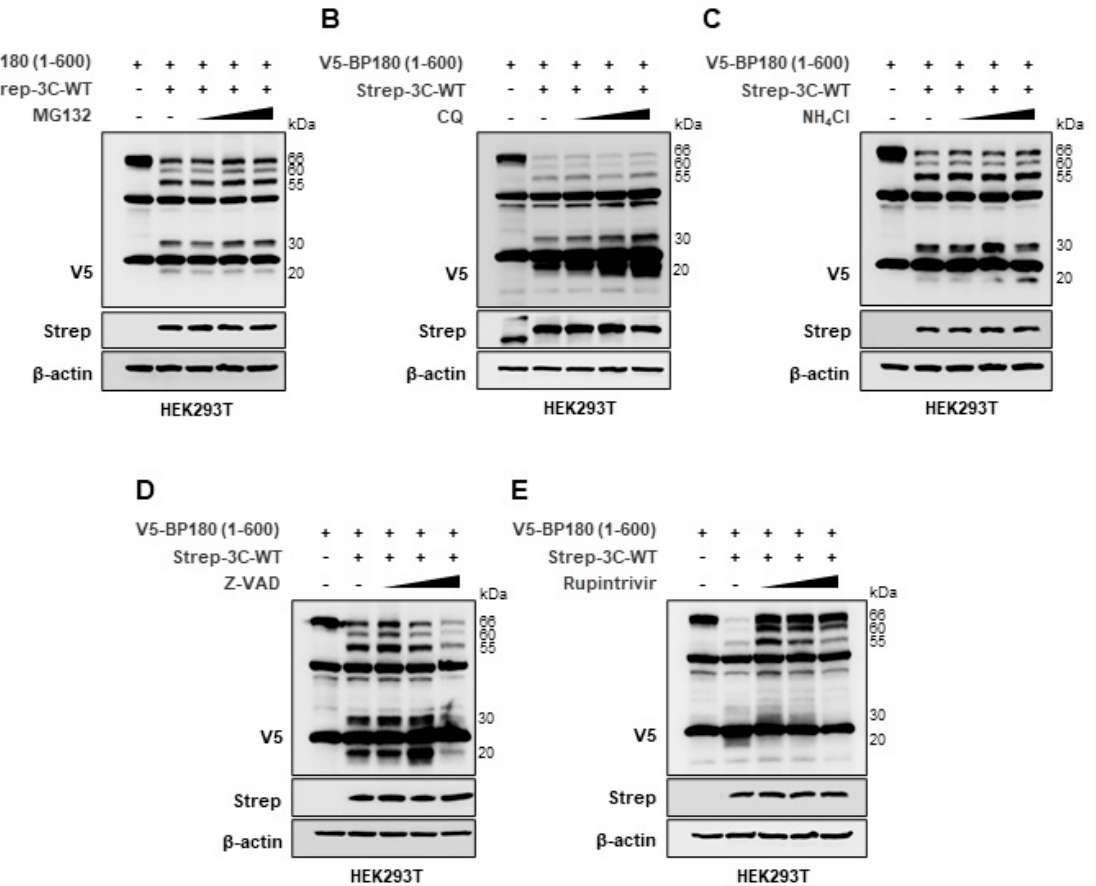
Figure 2. FMDV 3C pro degrades BP180 through its protease activity. HEK293T cells were transiently transfected with V5–tagged BP180 (1–600 aa) plasmid (1.5 µg) together with control plasmid or Strep–tagged FMDV 3C pro wild–type plasmid (80 ng), and treated with ( A ) MG132 (5, 10, 20 µM), ( B ) CQ (50, 100, 200 µM), ( C ) NH 4 Cl (10, 20, 50 mM), ( D ) Z–VAD (10, 50, 100 µM), or ( E ) Rupintrivir (10, 20, 40 µM). The HEK293T cells were treated with MG132 for 8 h before the samples were col ‐